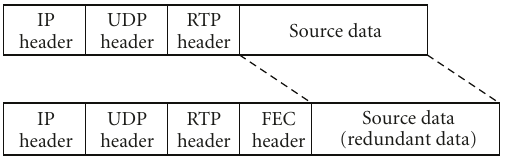
Figure 4: IP datagram format of RTP stream through FEC-on-